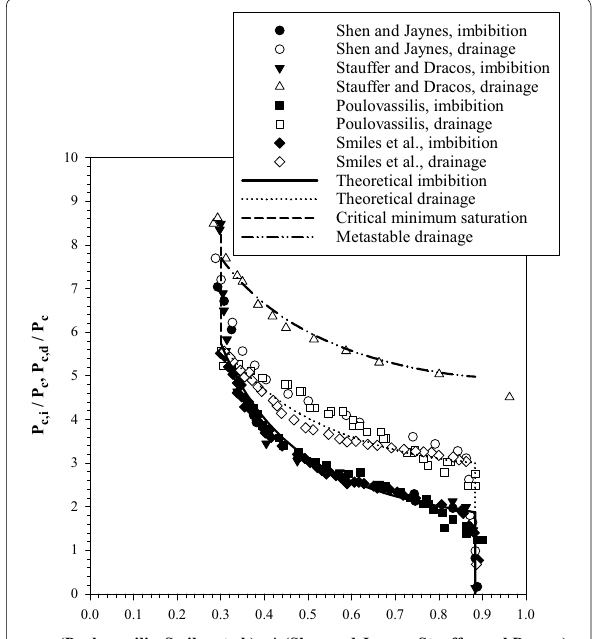
Fig. 2 Variation of imbibition and drainage pressures with relative saturation, corrected for fissure